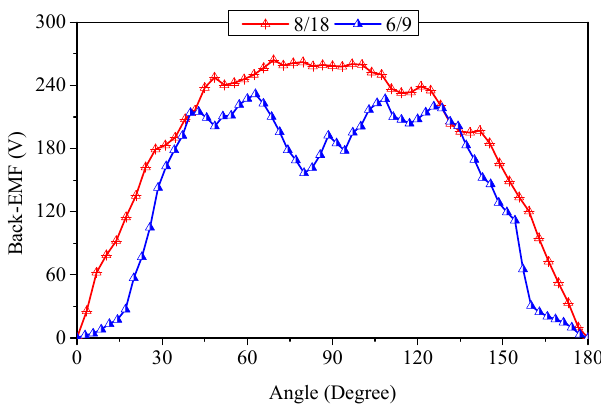
Figure 5. Back-electromotive forces (EMFs) with different pole-slot selection.